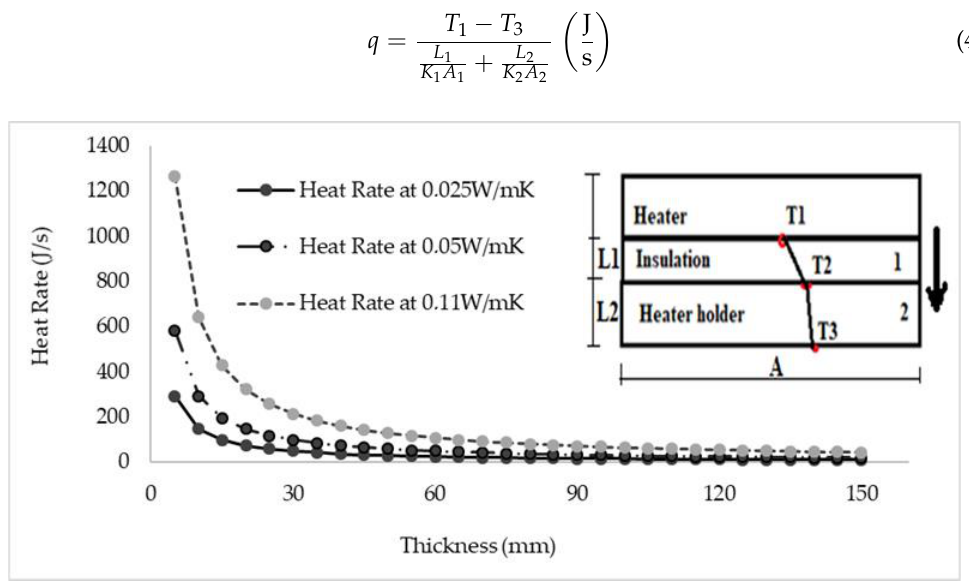
Figure 23. Heat rate vs. Insulation thickness at 0.025, 0.05, and 0.11 W/mK.